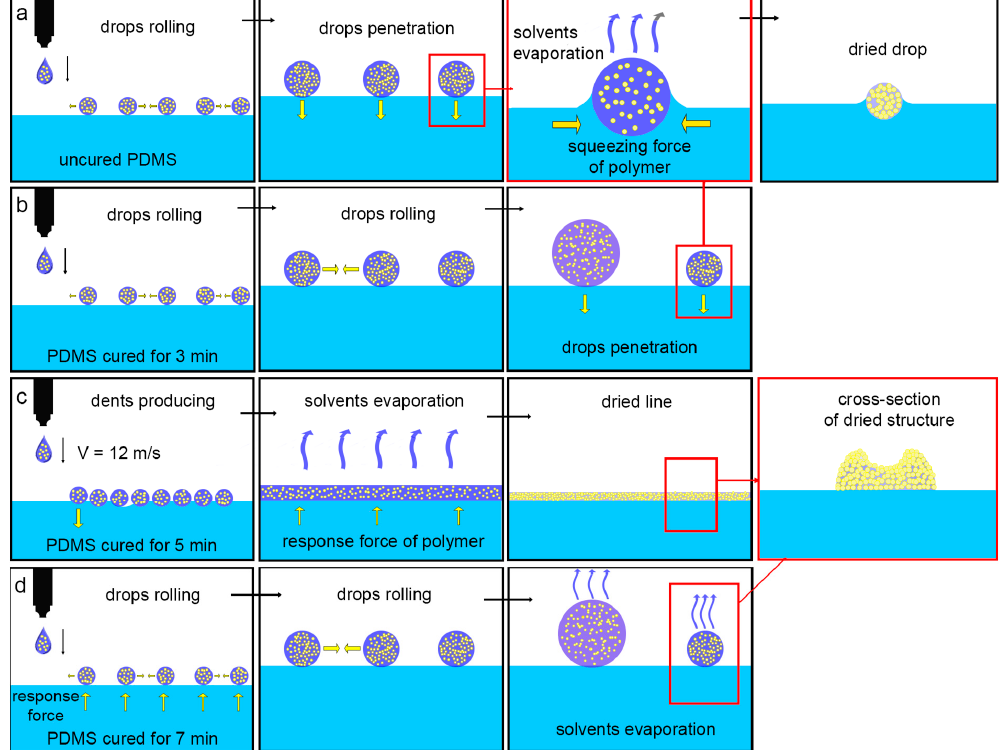
Figure 3. Schematic illustration of ink drops behavior printed on PDMS films cured for ( a ) 0, ( b ) 3, ( c ) 5, and ( d ) 7 min.